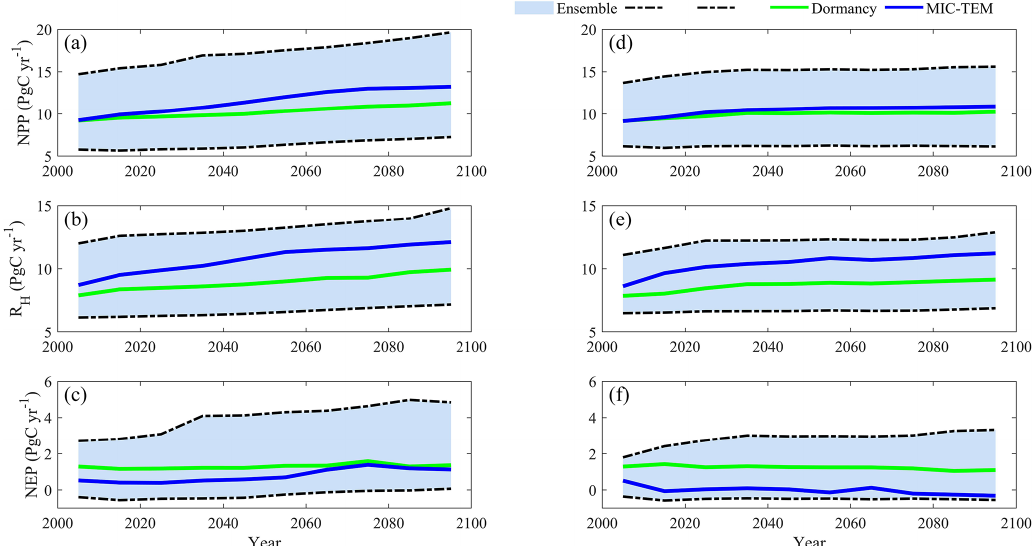
Figure 12. Simulated annual net primary production (NPP, a, d ), heterotrophic respiration ( R H , b, e ), and net ecosystem production (NEP, c, f ) under the RCP8.5 scenario (a–c) and RCP2.6 scenario (d–f) by MIC-TEM-dormancy with an ensemble of parameters. The decadal running mean is applied. The grey area represents the upper and lower bounds of